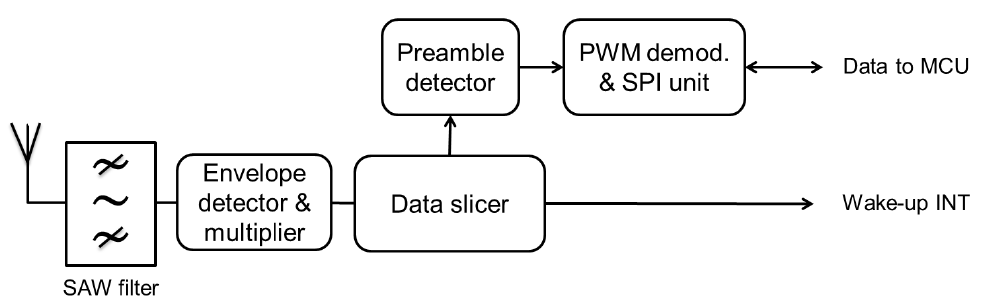
Figure 17. The low-complexity WuRx in